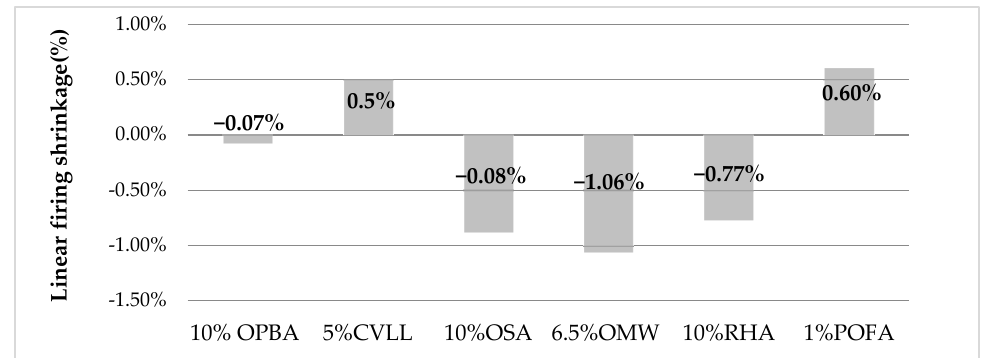
Figure 2. Linear firing shrinkage for samples made with lignocellulosic biomass ash: olive bottom ash (OPBA) [60], combustion of olive pomace (CVLL) [61], olive stone ash (OSA) [62], oil mill wastewater (OMW) [63], Rice Husk ash (RHA) [63], palm oil fuel ash (POFA) [70].